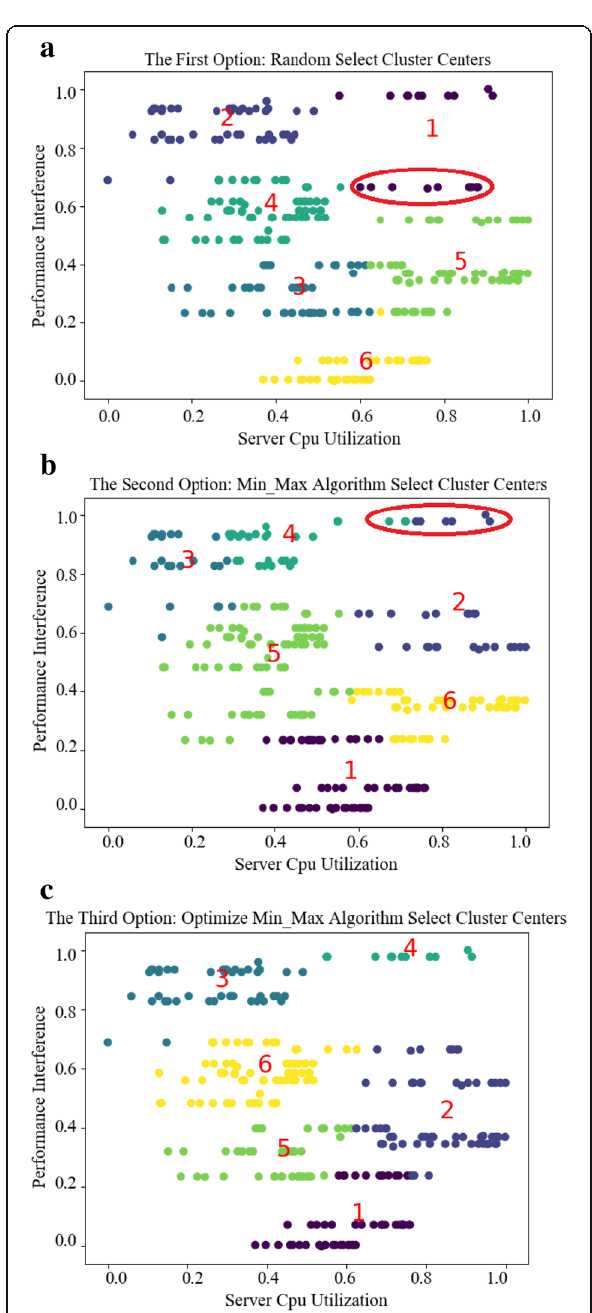
Fig. 5 a Random algorithm for selecting initial clustering centers. b Min-max algorithm for selecting initial clustering centers. c Optimizing min-max algorithm for selecting initial clustering